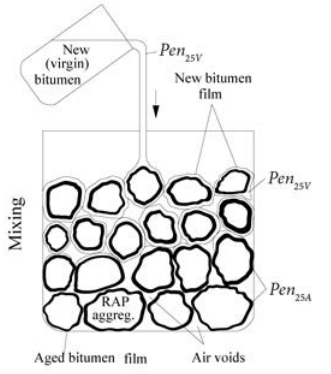
Fig. 1. Conversion of the virgin bitumen from bulk condition into films coating RAP particles in the beginning of the mixing